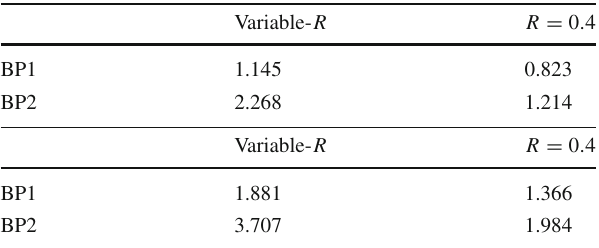
Table 2 Cross sections (in pb) of signal and background processes upon enforcing the reduced cuts plus the mass selection criteria | m − m | < 50 GeV and bbbb H | m − m | < 20 GeV for the bb h various jet reconstruction procedures